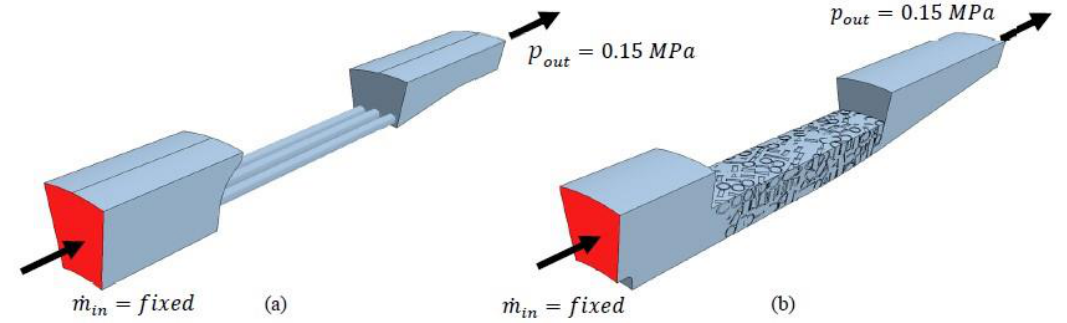
Figure 11. Reduced domain used for the grid independence study for the ( a ) MCs and the ( b ) RRs.